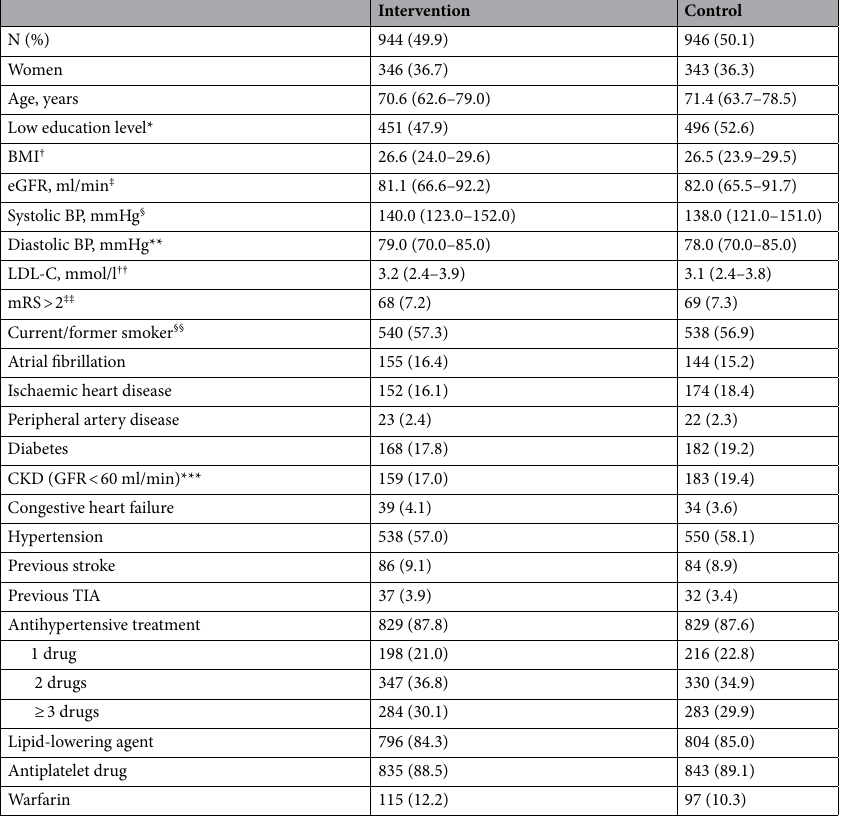
Table 1. Baseline characteristics of the study population. Data are given as N (%) or median (interquartile range). No significant differences were present except a higher proportion of participants with low education in the control group ( p = 0.040). Low education level was defined as no more than 10 years of formal education. Drug treatment variables refer to treatment at discharge. BMI, body mass index; eGFR, estimated glomerular filtration rate; BP, blood pressure; LDL-C, low-density lipoprotein cholesterol; CKD, chronic kidney dysfunction; TIA, transient ischemic attack. *Missing values for 3 control group participants and 2 intervention group participants. † Missing values for 2 control group participants and 1 intervention group participant. ‡ Missing values for 3 control group participants and 9 intervention group participants. § Missing values for 11 control group participants and 18 intervention group participants. **Missing values for 4 control group participants and 3 intervention group participants. †† Missing values for 34 control group participants and 39 intervention group participants. ‡‡ Missing values for 4 control group participants and 2 intervention group participants. §§ Missing value for 1 intervention group participant. ***Missing values for 3 control group participants and 9 intervention group